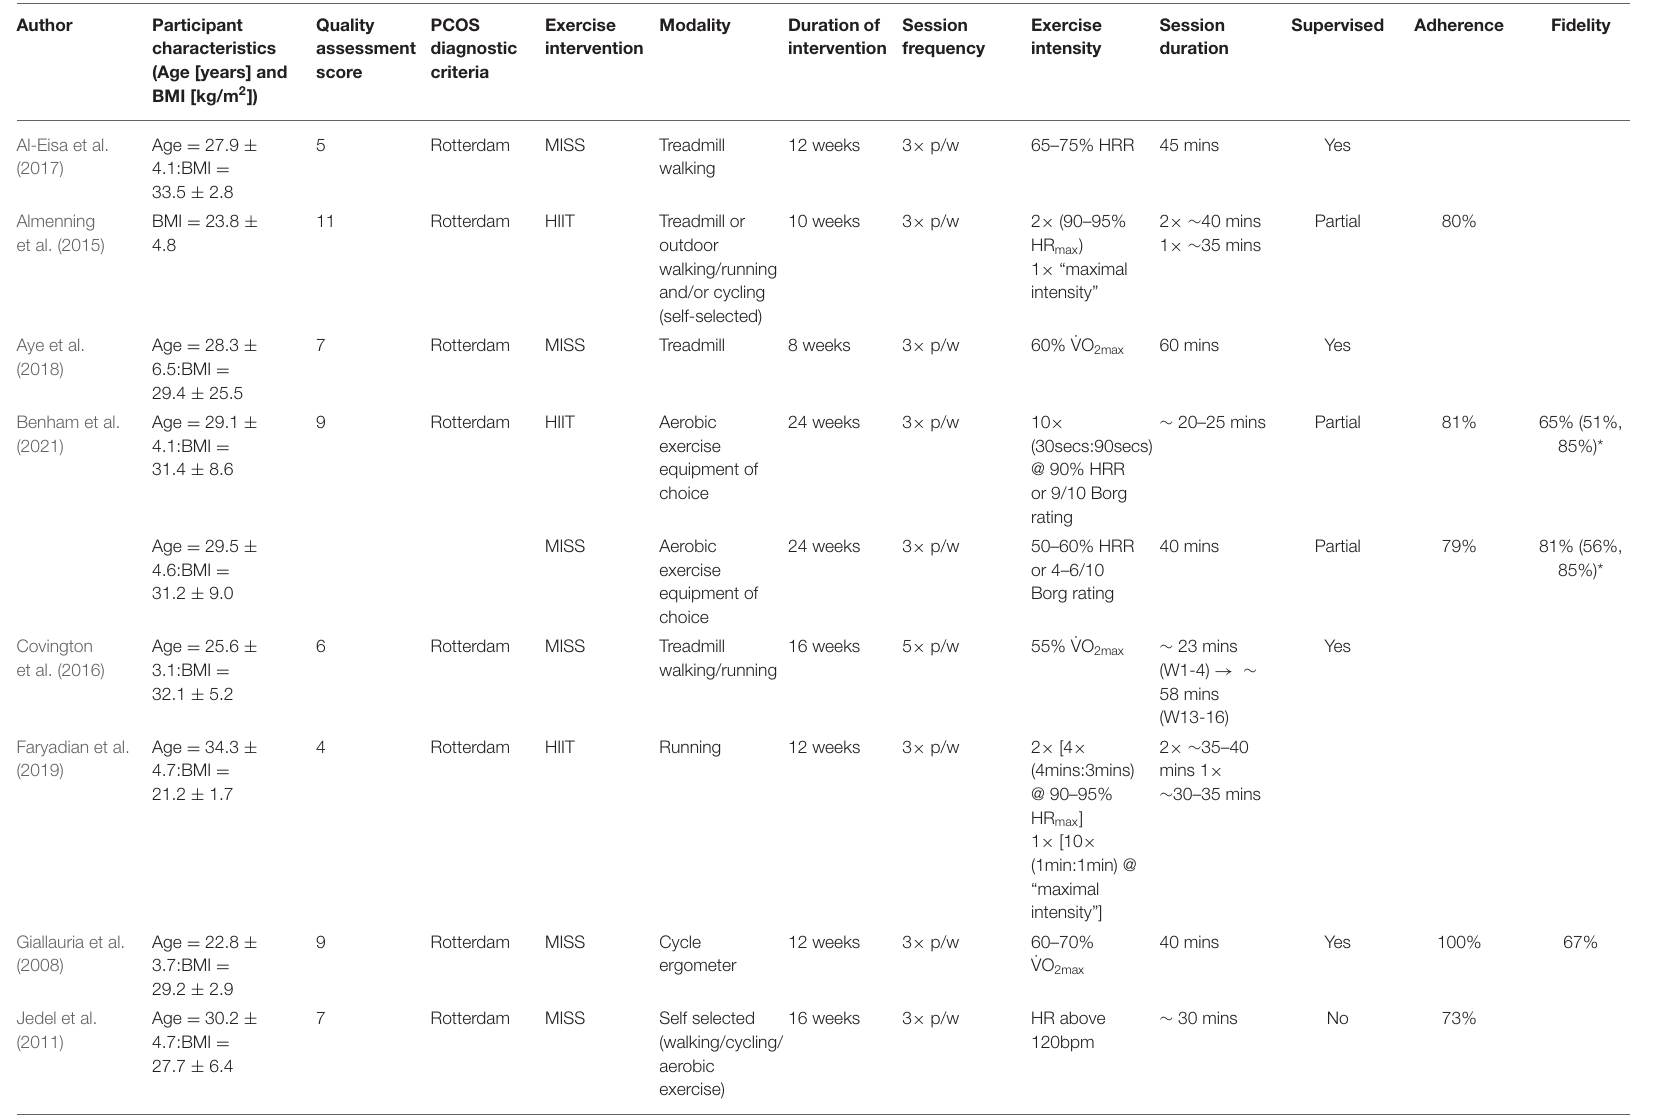
TABLE 2 | Study characteristics and quality assessment